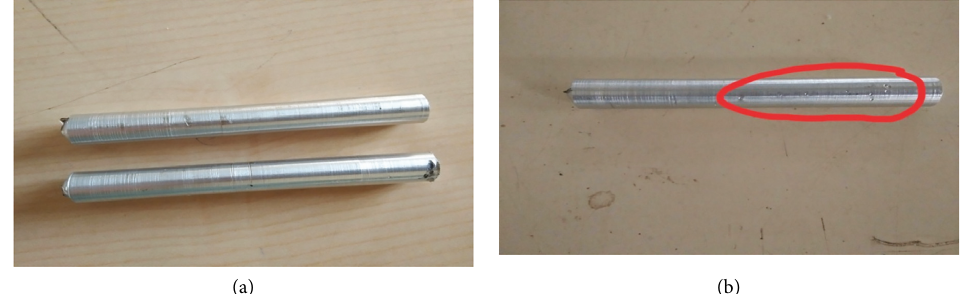
Figure 20: (a) Specimen before hardness testing. (b) Specimen after hardness testing.